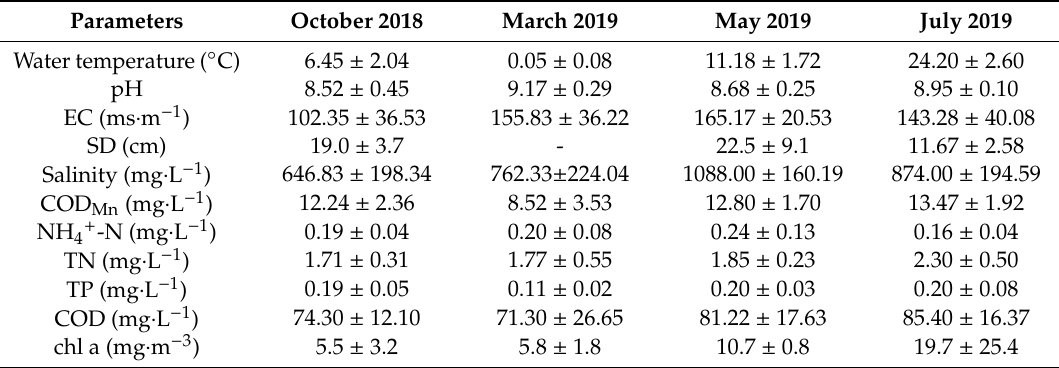
Table 1. Basic physical and chemical parameters of the overlying water of Lake Hulun.